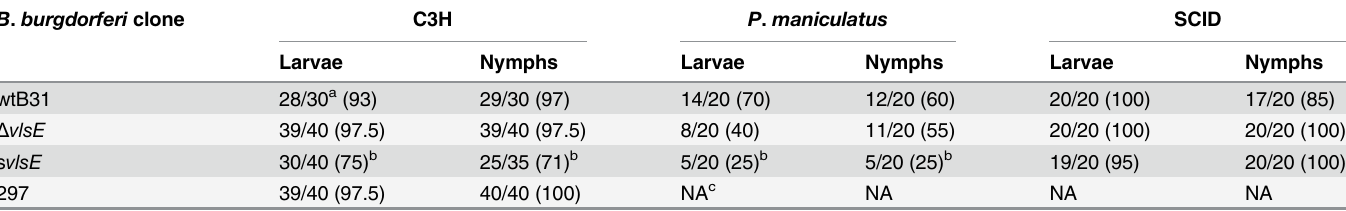
Table 4. Infectivity rates of B . burgdorferi in Ixodes scapularis larvae fed on C3H, P . maniculatus and SCID mice and respective B . burgdorferi sur- vival rates in flat